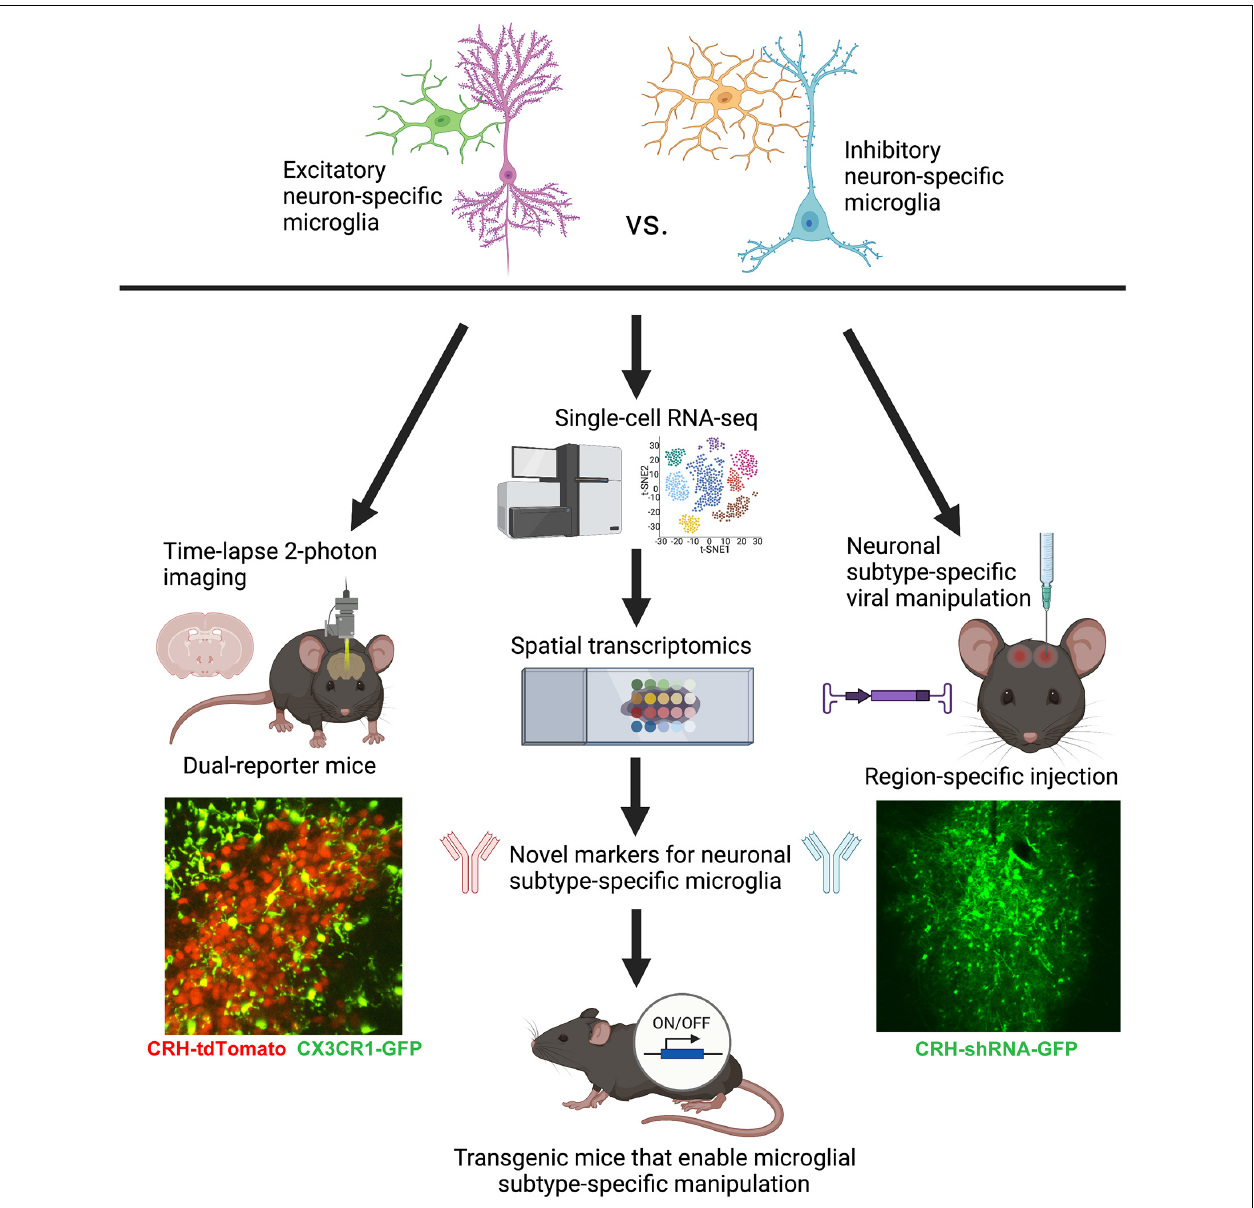
FIGURE 2 | Conceptual figure displaying the proposed technical considerations and future studies that would advance the field of microglial biology by enabling the study of neuronal subtype-specific microglia (e.g., excitatory- vs. inhibitory-specific). Lower left: representative still-frame of a 2-photon time-lapse video recorded from an acute slice of the PVN from a P8 CRH-tdTomato+/-; CX3CR1-GFP+/- mouse. Adapted from Bolton et al. (2022). Lower right: representative image of a lentiviral injection of CRH-shRNA (labeled with GFP) into the central nucleus of the amygdala. Adapted from Bolton et al. (2018). Figure created with